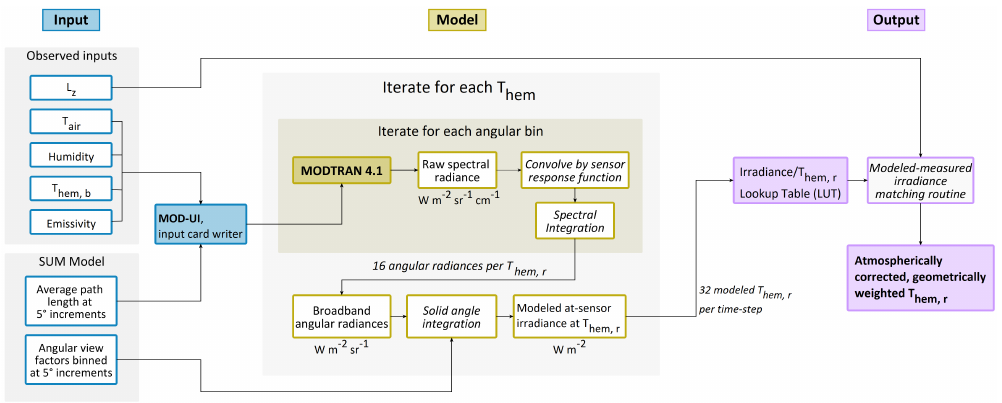
Figure 3. A workflow schematic depicting the input, model, and output-processing steps of a “rolling lookup table method” for hemispherical radiometric surface temperature retrieval. Italicized text indicates